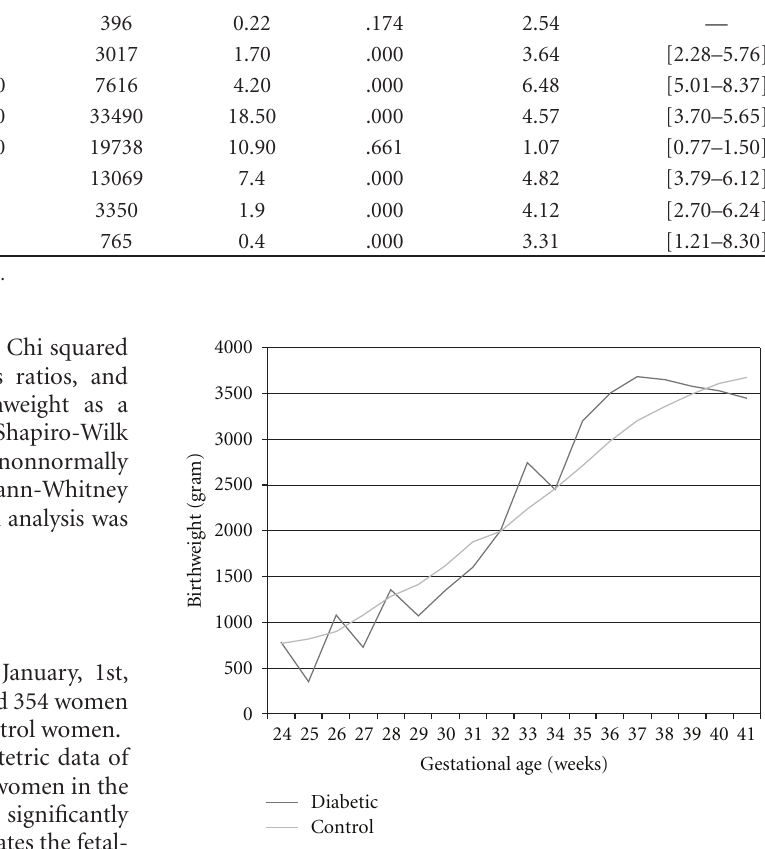
Figure 1: Median birthweight versus gestational